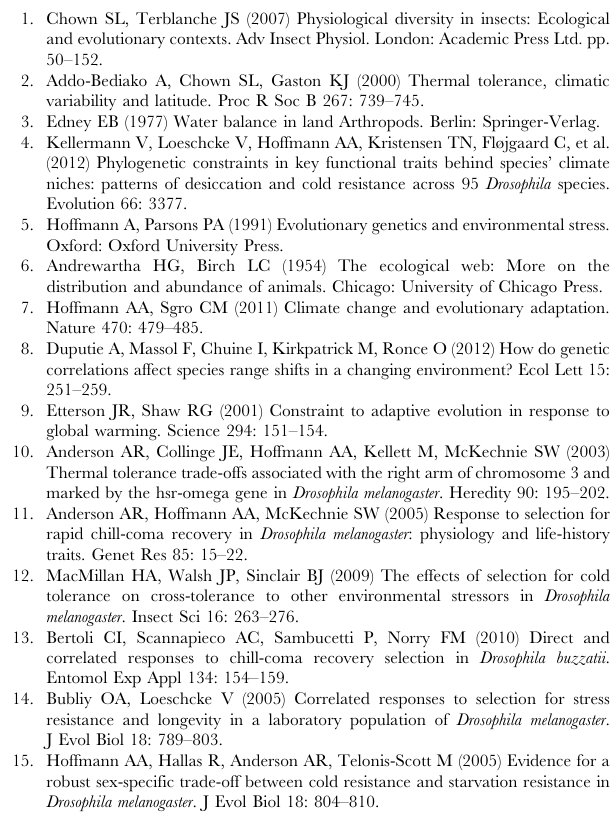
Table S1 Regression analysis for the association be- tween environmental variables, starvation resistance and body size. Relationship between starvation resistance (starv) and body size for latitude and seven environmental variables; annual mean temperature (amt), maximum temperature of the warmest month (T max ), temperature seasonality (Tsea), log annual precipitation (Pann). precipitation of the driest month (Pdry), precipitation of the wettest month (Pwet) and precipitation seasonality (Psea).A multiple regression approach was taken to examine the relationship between starvation and body size and multiple environmental variables. The explanatory power of both the single and multiple predictor models is given. Significant P values and the model with the best Akaike Information Criterion (AIC) are highlighted in bold. Table S2 Estimates of phylogenetic signal for starvation resistance and body size. Phylogenetic signal was assessed through alternative methods. l and K range from no phylogenetic signal l and K =0 to high phylogenetic signal with l = 1, K $ 1. Significance of l is tested against a model where l = 0 and l = 1 the estimate with the best corrected Akaike Information Criterion (AICc) is given in bold. The SLOUCH method estimates phylogenetic signal by fitting an Ornstein-Uhlenbeck ( OU ) model . Phylogenetic signal is estimated through the t half-life (t 1/2 ) where a t 1/2 . 0 reflects an increasing association between the phylogeny and the trait (t 1/2 has the same units as the phylogeny, here tree height =1). Moran’s I provides an estimate of the autocorrelation found within a dataset at three taxonomic levels: subgenus (SubG),